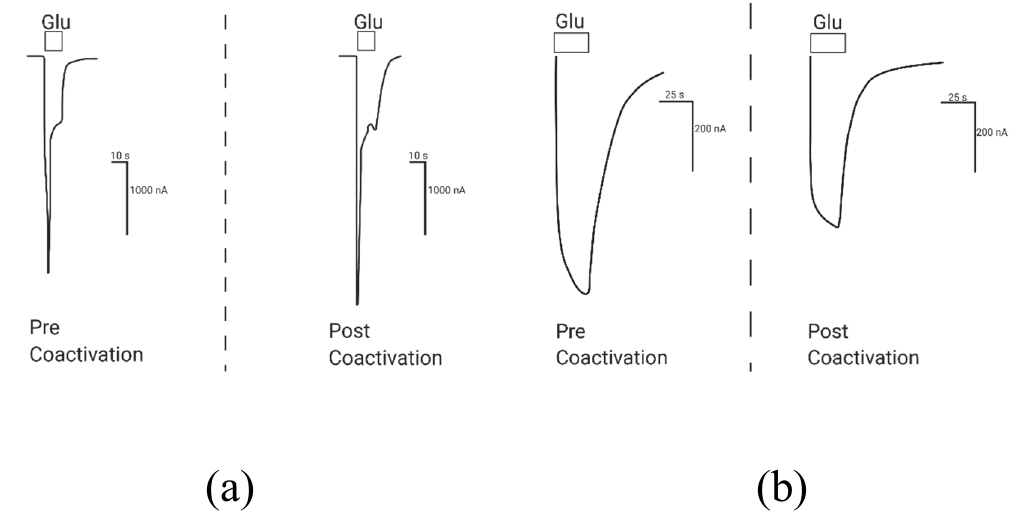
Figure A6. Altered response to Glu after P2X4–NMDAR coactivation. Representative current recorded from individual oocytes expressing P2X4 and NMDARs, responding to 2 µ M Glu before (left) and after (right) Glu + ATP coactivation, in the presence ( a ) or absence ( b ) of calcium.